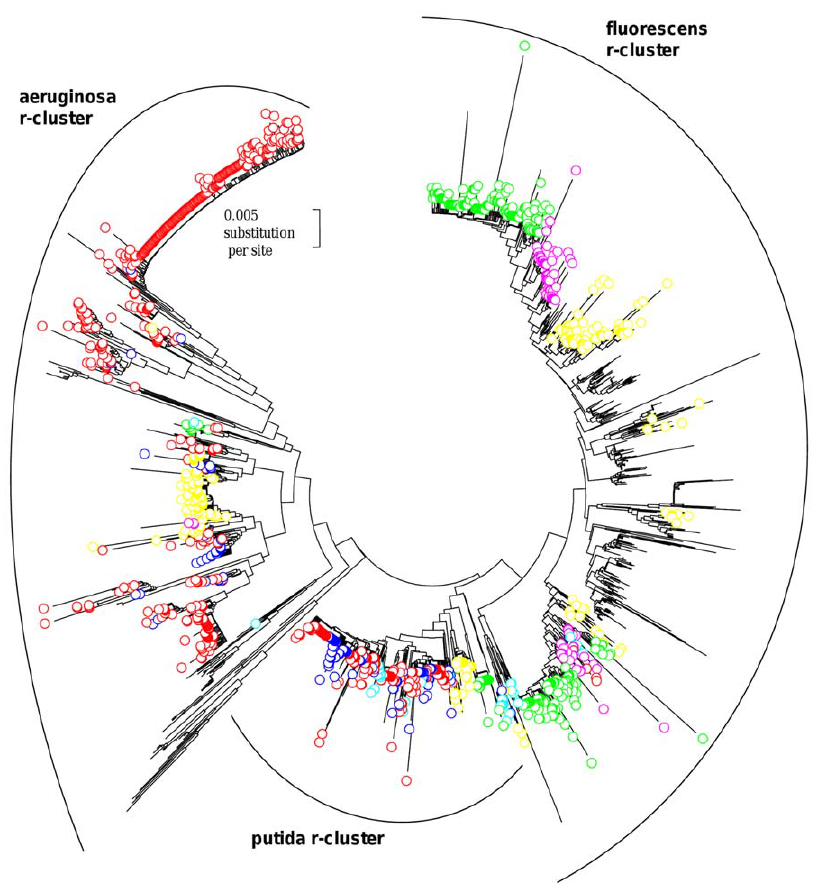
Figure 5. Phylogenetic occurrence of the major V3 hypervariable motifs. The phylogenetic tree was built from 1803 full-length 16S rRNA sequences of Pseudomonas available in the databases, after excluding the V1 region (see Figure S7). Each colour corresponds to a V3 motif found in at least two r-clusters. For the sake of visibility, only the six major V3 motifs (see Table 4) are shown, from the most represented (red circle), in this descending order: red, green, yellow, dark blue, purple, and light blue circles. The sequences highlighted by a green circle have the V3 motif found in the minor allele (allele a) of the 16S rRNA gene in the MFY30 strain.